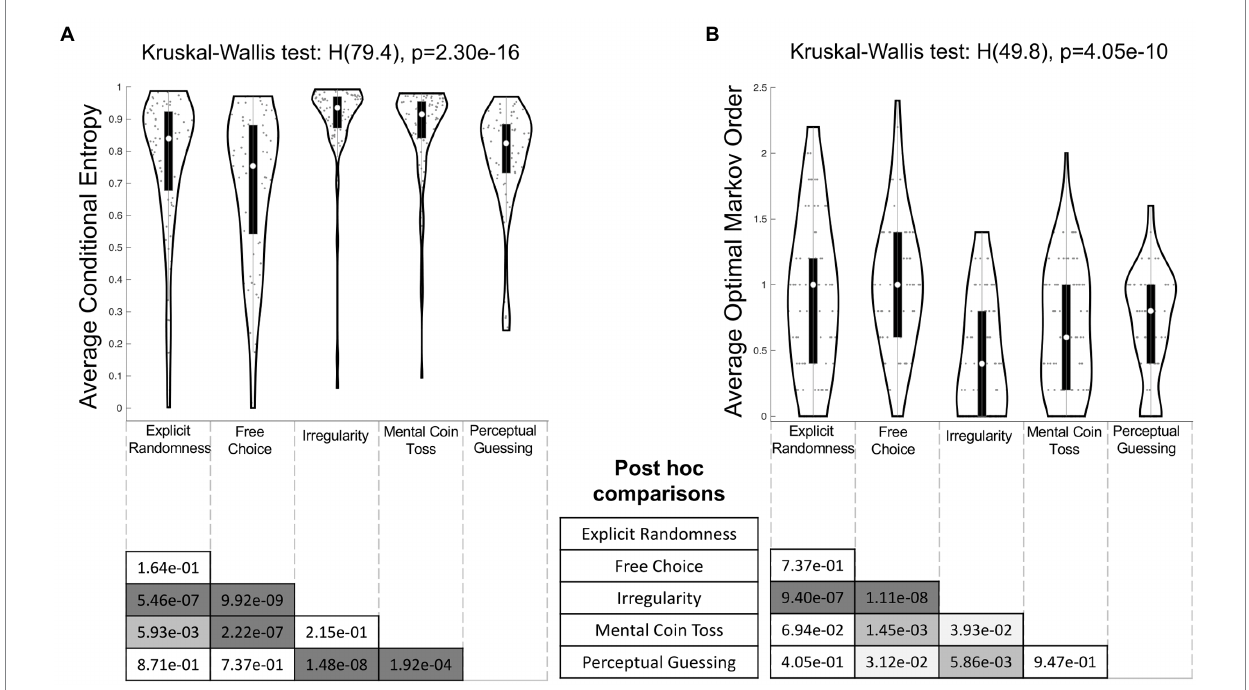
FIGURE 6 Tukey–Kramer adjusted post hoc comparisons of (A) average conditional entropy values and (B) optimal Markov orders between conditions. The outline of each violin plot shows the kernel density estimate, the black bars in the center indicate the interquartile range with the white dot representing the median. The x -axis labels of the violin plots serve as the columns for the half matrices in the bottom, so that each entry displays the p value of the comparison between the intersecting pair of row and column conditions. Color code of matrix entries: dark grey: p < 0.001, middle grey: p < 0.01, light grey: p < 0.05, white: not